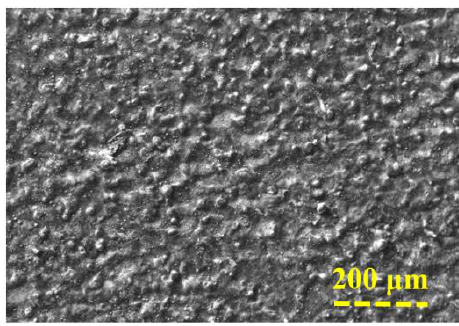
Figure 1. Microstructure images of the